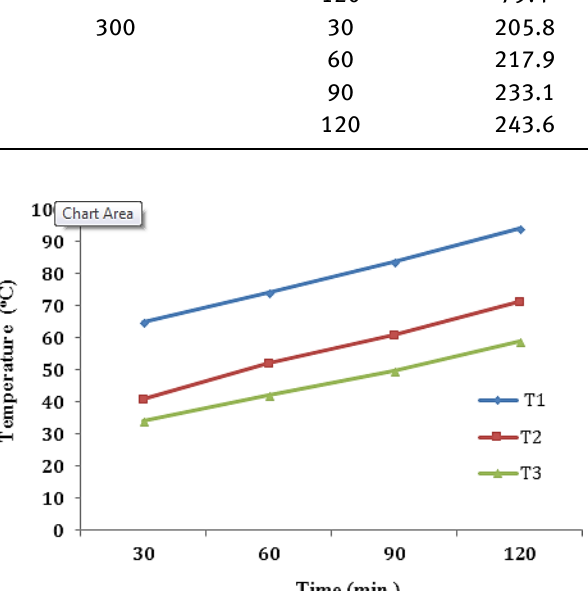
Figure 6: The temperature distribution of uncoated specimen at a constant source temperature of 300 ∘ C